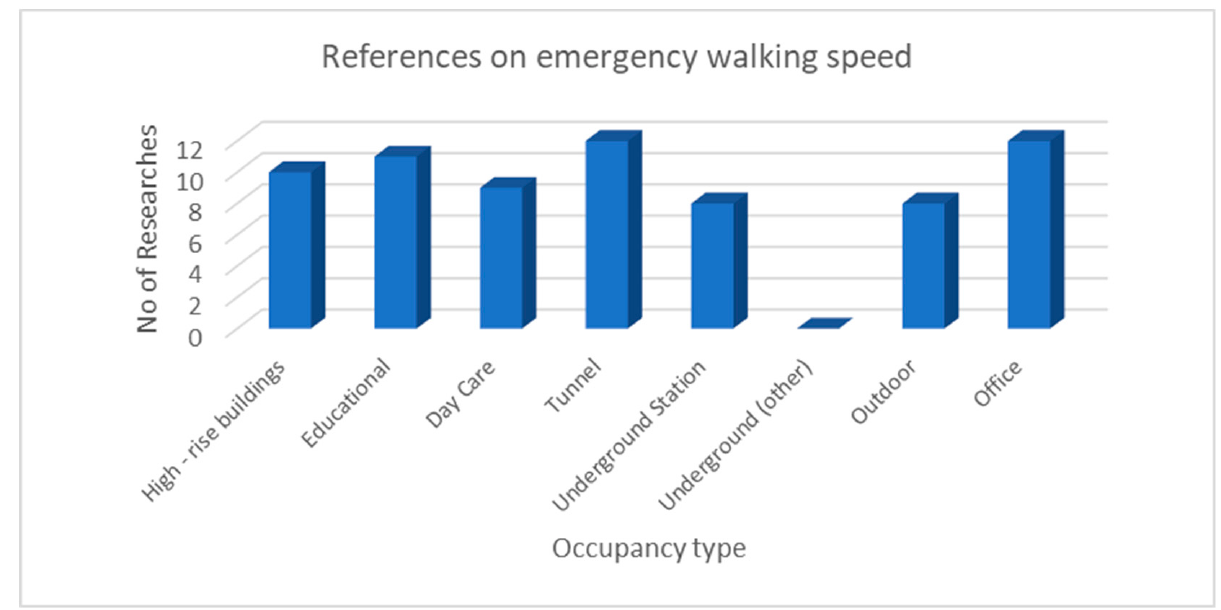
Figure 1. Number of research studies by occupancy type. As seen from the Table above, regarding the evacuation speed of occupants, there is a variation concerning the type of occupants, building type, visibility conditions, human psychology and